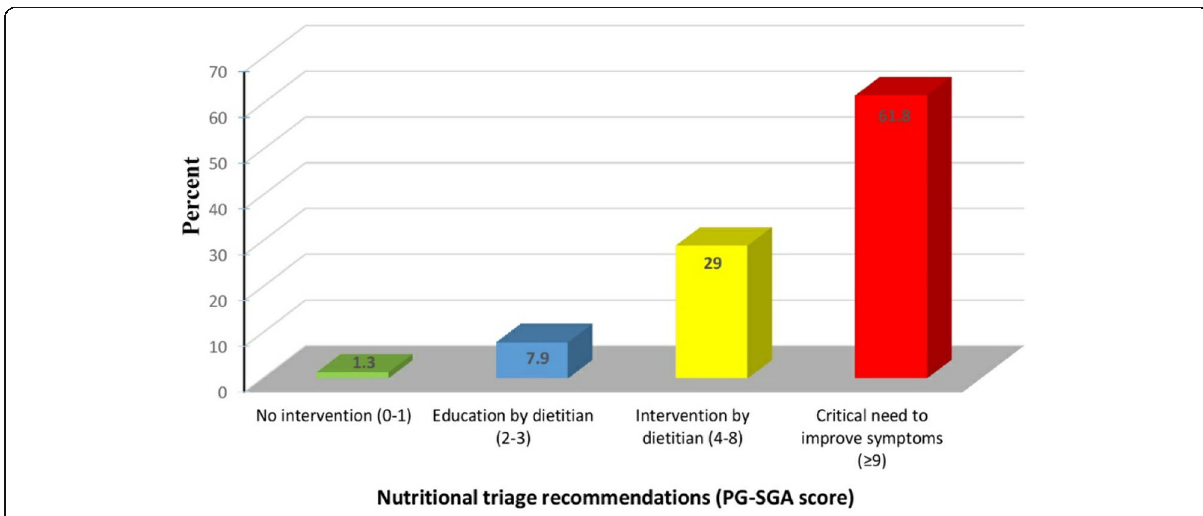
Fig. 2 Nutritional triage recommendations according to the patient-generated subjective global assessment (PG-SGA) score of the studied multiple sclerosis patients at Kasr Al-Ainy